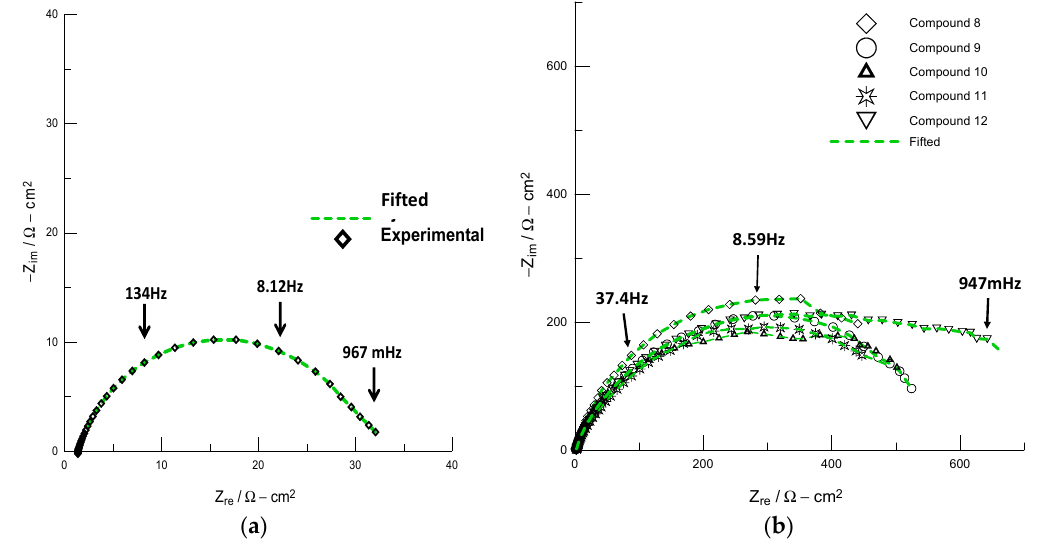
Figure 2. Nyquist plots recorded in the following systems: ( a ) API 5 L X52/1 M HCl and ( b ) API 5 L X52/1 M HCl +10 ppm of compounds 8 – 12 . Table 3. Electrochemical parameters obtained from experimental impedance data including the corrosion inhibition efficiencies (IE) at 10 ppm of the organic inhibitor.